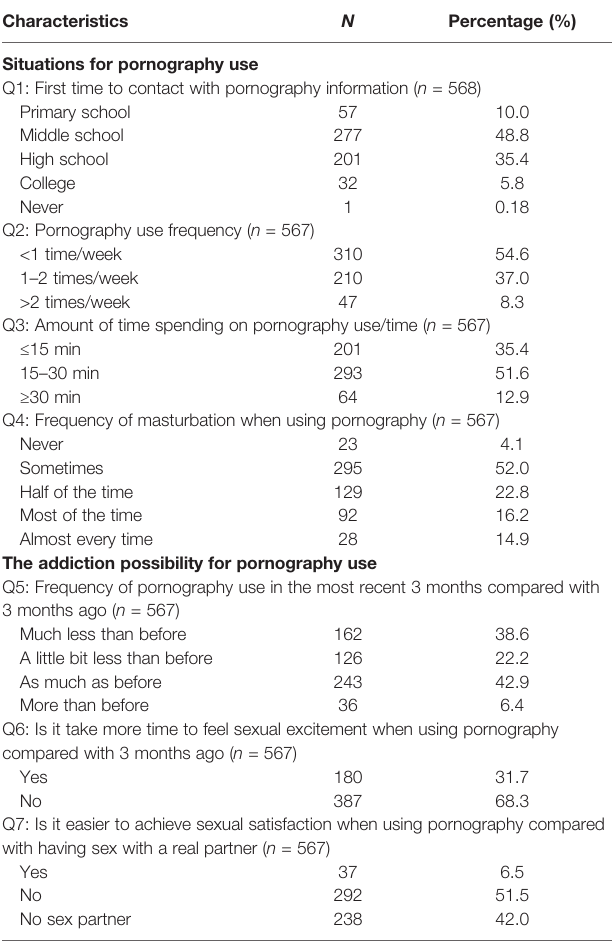
TABLE 2 | The distribution of pornography use-related questions.